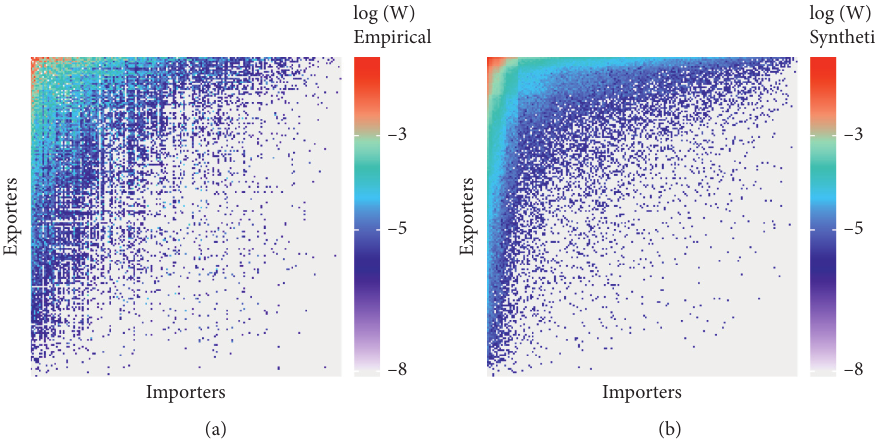
Figure 1: Empirical and synthetic trade matrices for year 2017. Normalized weight matrices W Color is assigned according to the normalized weight of that particular yearly trade volume. The synthetic matrix is the result of running a particular experiment. Both matrices have equal number of nodes and